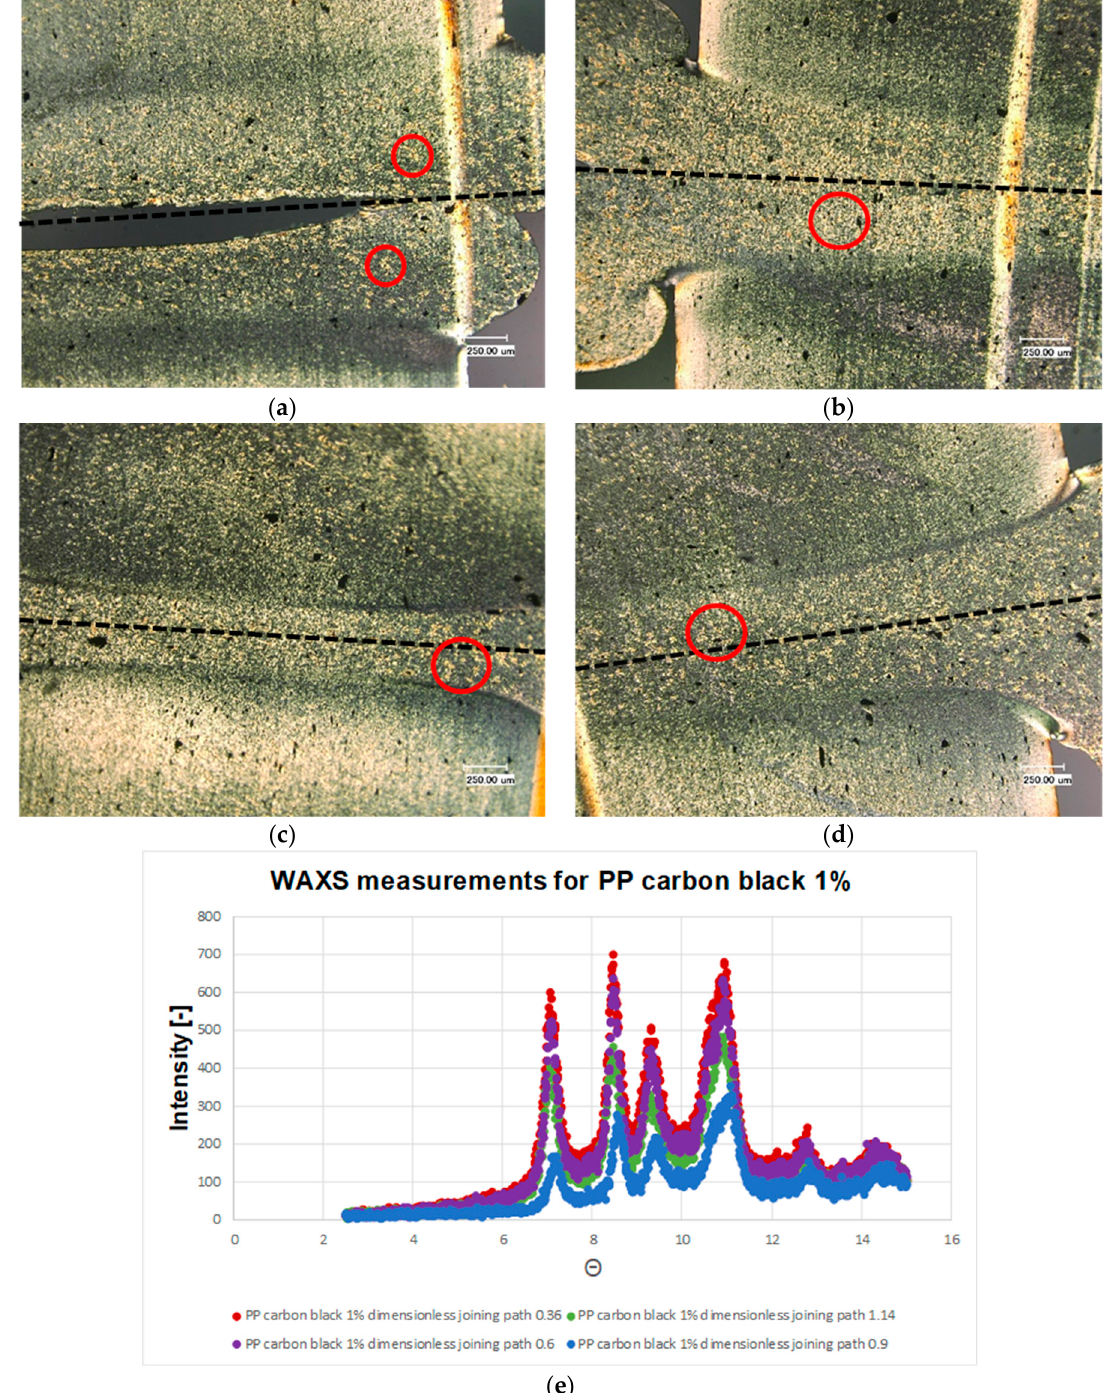
Figure 7. Microstructures of the welded PP carbon balck 1 with dimensionless joining path ( a ): 0.3; ( b ): 0.5; ( c ): 0.75; ( d ): 0.95; ( e ): WAXS measurement results of the welded PP carbon balck 1 for different joining paths. ● α -structure ● β -structure.